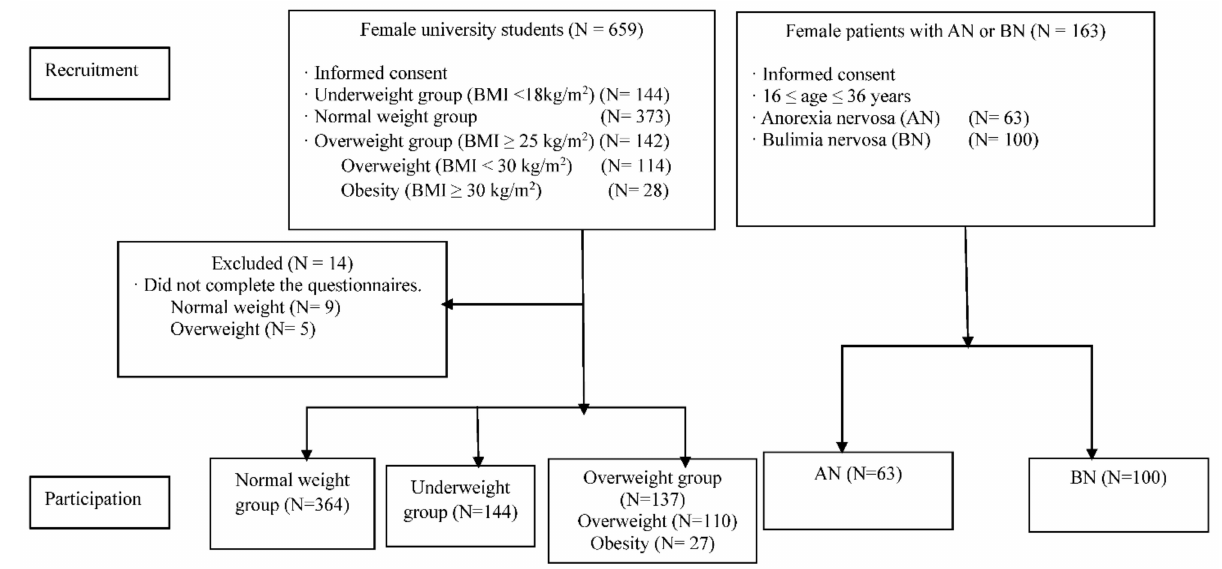
Figure 1. Flow chart of study participants. AN: anorexia nervosa; BN: bulimia